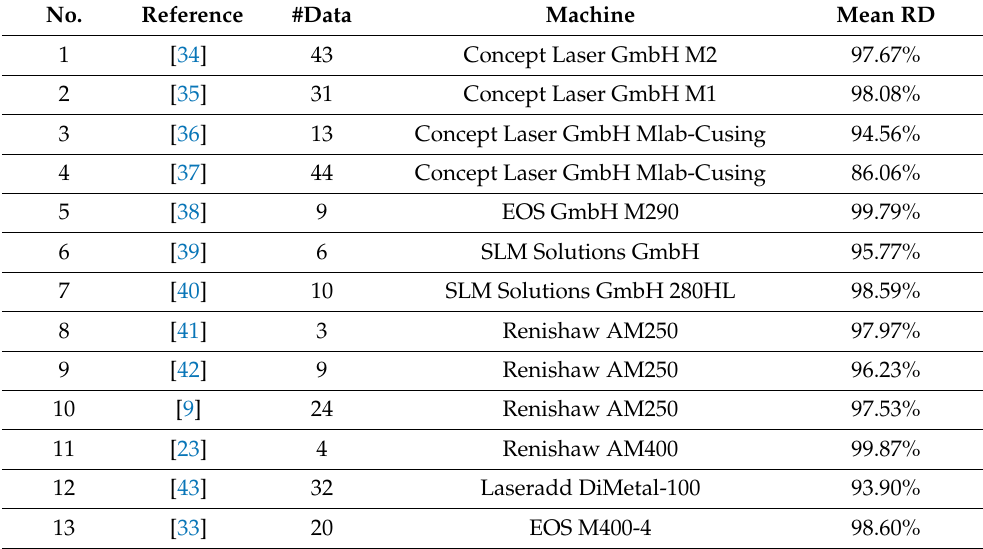
Table 1. Studies from the literature used for data collection.